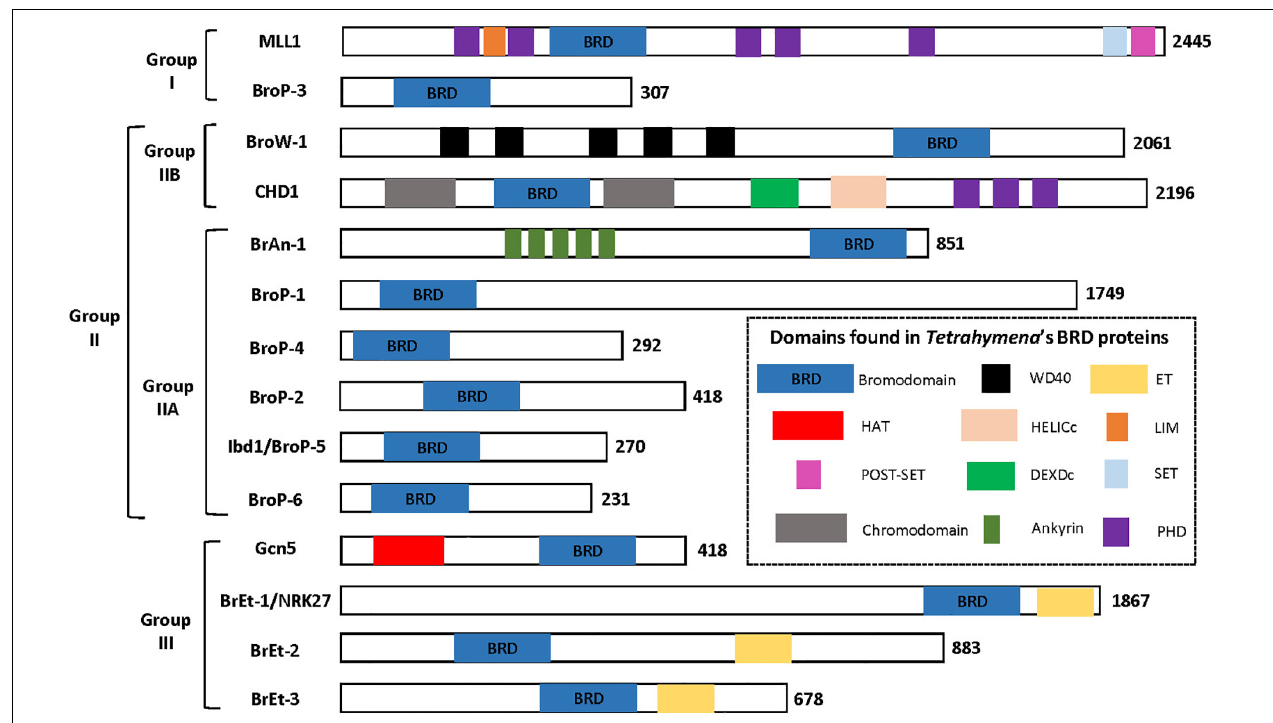
FIGURE 4 | Tetrahymena’s 14 BRD proteins grouped based on phylogenetic analysis of BRD sequence. Figure adapted from Saettone et al. (2018).